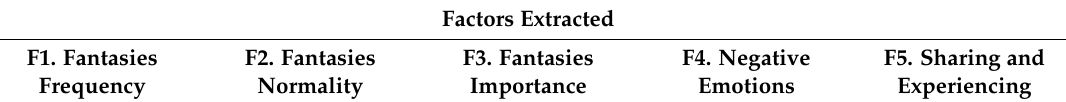
Table 2. Principal component analysis matrix (n = 887)—SDEF2’s 21 items extracted from the 26-pilot tested